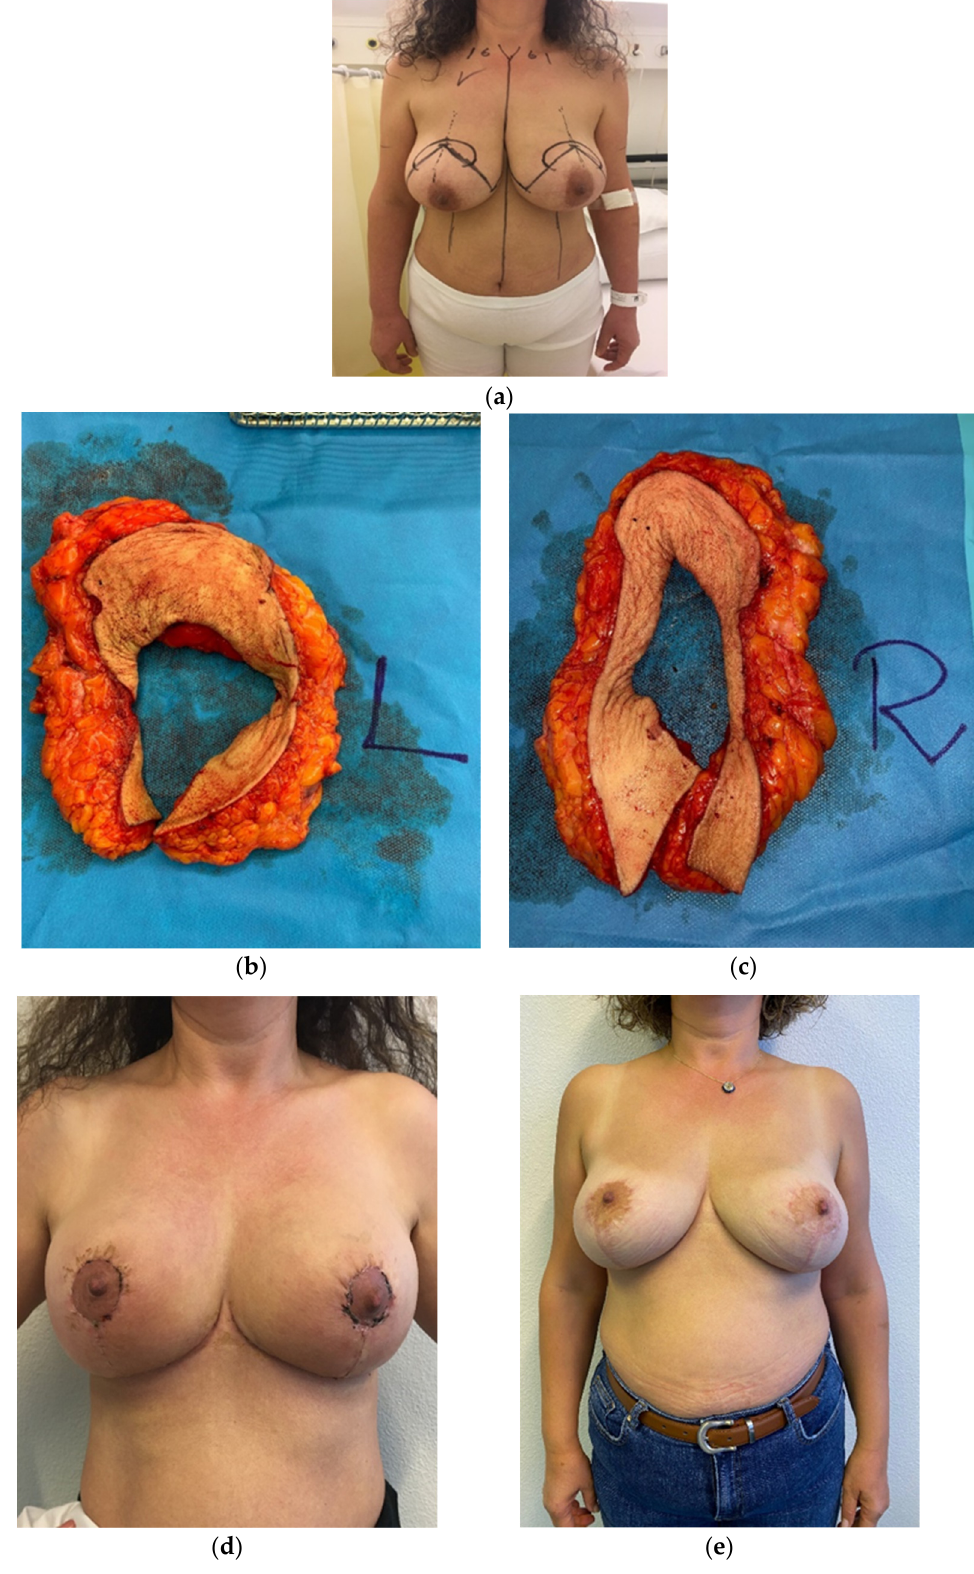
Figure 2. A female patient, who undergone an omega resection pattern tecnique inferior-pedicle based. The patient is shown pre-operatively ( a ), two weeks ( d ), and six months ( e ) after surgery. En-bloc breast parenchyma omega shaped resection ( b , c ).